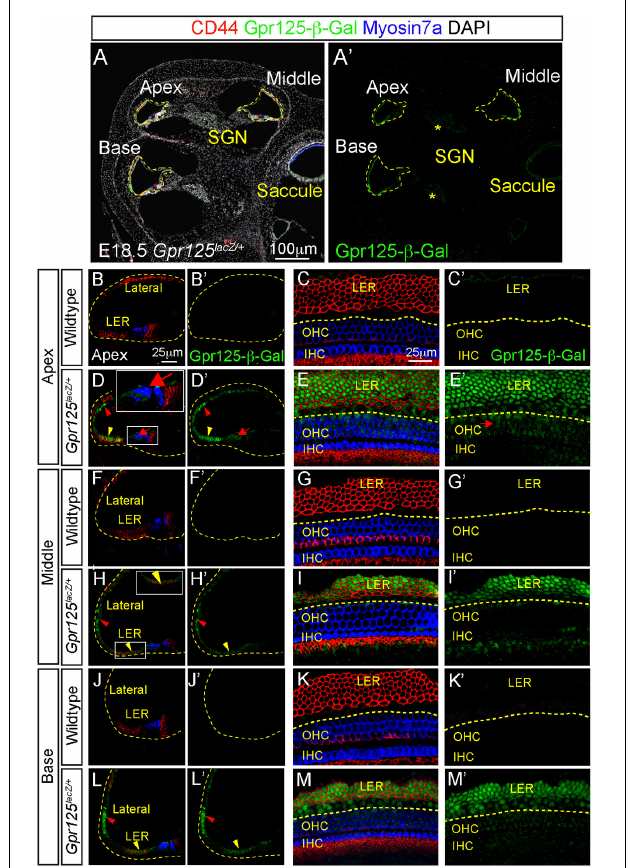
FIGURE 2 | Expression patterns of Gpr125 in E18.5 Gpr125 lacZ / + mice. (A,A’) Representative images of midmodiolar cochlear sections of E18.5 Gpr125 lacZ / + mice immunostained for Gpr125- β -Gal (green), CD44 (red), and Myosin7a (blue). Gpr125- β -Gal expression located in the LER, lateral cochlear wall, OHCs and SGNs (asterisks). (B–C’) CD44 marks the LER and inner phalangeal cells inside the cochlear duct and also the mesenchymal cells outside the roof. No Gpr125- β -Gal expression was observed in the wild-type cochleae. (D,D’) Gpr125- β -Gal expression was detected at the LER (yellow arrowhead) extending to the lateral cochlear wall (red arrowhead) at the apical turn of Gpr125 lacZ / + cochlea. Low expression was also noted in outer hair cells (red arrows). (E,E’) Confocal images of whole mount cochlea (apical turn shown) from E18.5 Gpr125 lacZ / + mice showing co-expression of Gpr125- β -Gal and CD44 in the LER. Gpr125- β -Gal expression was also detected in the CD44-negative Hensen’s cells and OHCs (red arrows). (F–G’) No Gpr125- β -Gal signal was detected at the middle turns of the wild-type cochlea. (H–I’) Like the apical turn, Gpr125- β -Gal was detected in the lateral cochlear wall and LER in the middle turn of Gpr125 lacZ / + cochlea (red and yellow arrowheads, respectively). Gpr125- β -Gal was not detected in hair cells. (J–K’) No Gpr125- β -Gal signal was detected at the base of the wild-type cochlea. (L–M’) Gpr125- β -Gal is expressed in the LER and lateral cochlear wall in the base turn of Gpr125 lacZ / + cochlea. High-magnification images shown in inset for panels (D,H) . GER, greater epithelial ridge; LER, lesser epithelial ridge; IHC, inner hair cells; OHC, outer hair cells; SGN, spiral ganglion